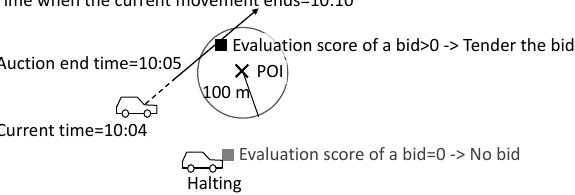
Figure 16. Example of decision-making by a mobile host on whether to tender a bid based on an evaluation score of a bid.